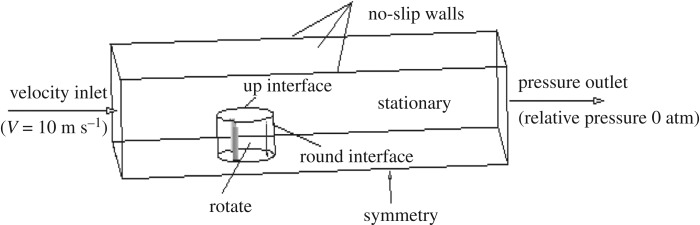
Boundary conditions.